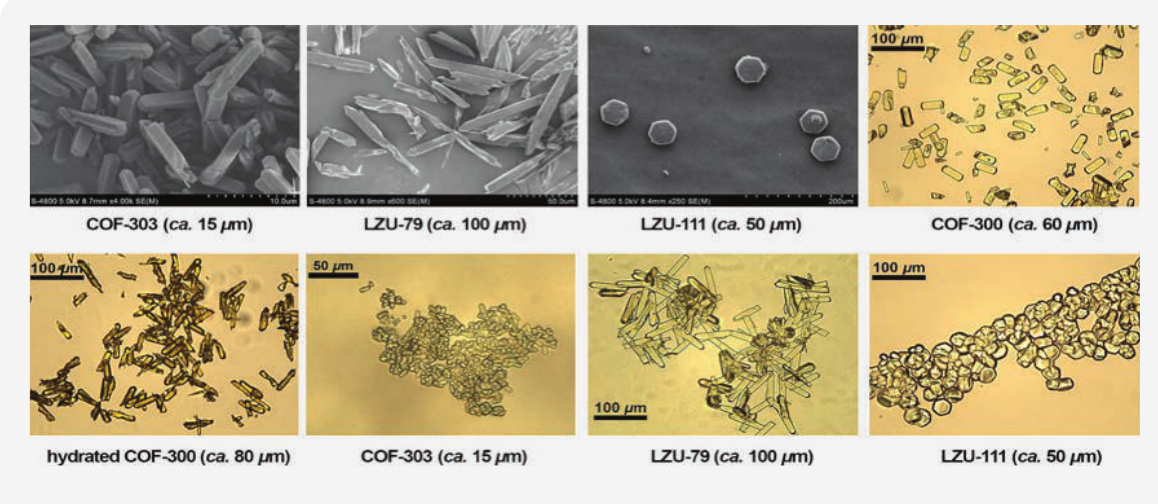
Fig. 11. Large single crystals of COFs have allowed characterization of COFs on the atomic level with the same precision routinely practiced in small molecule